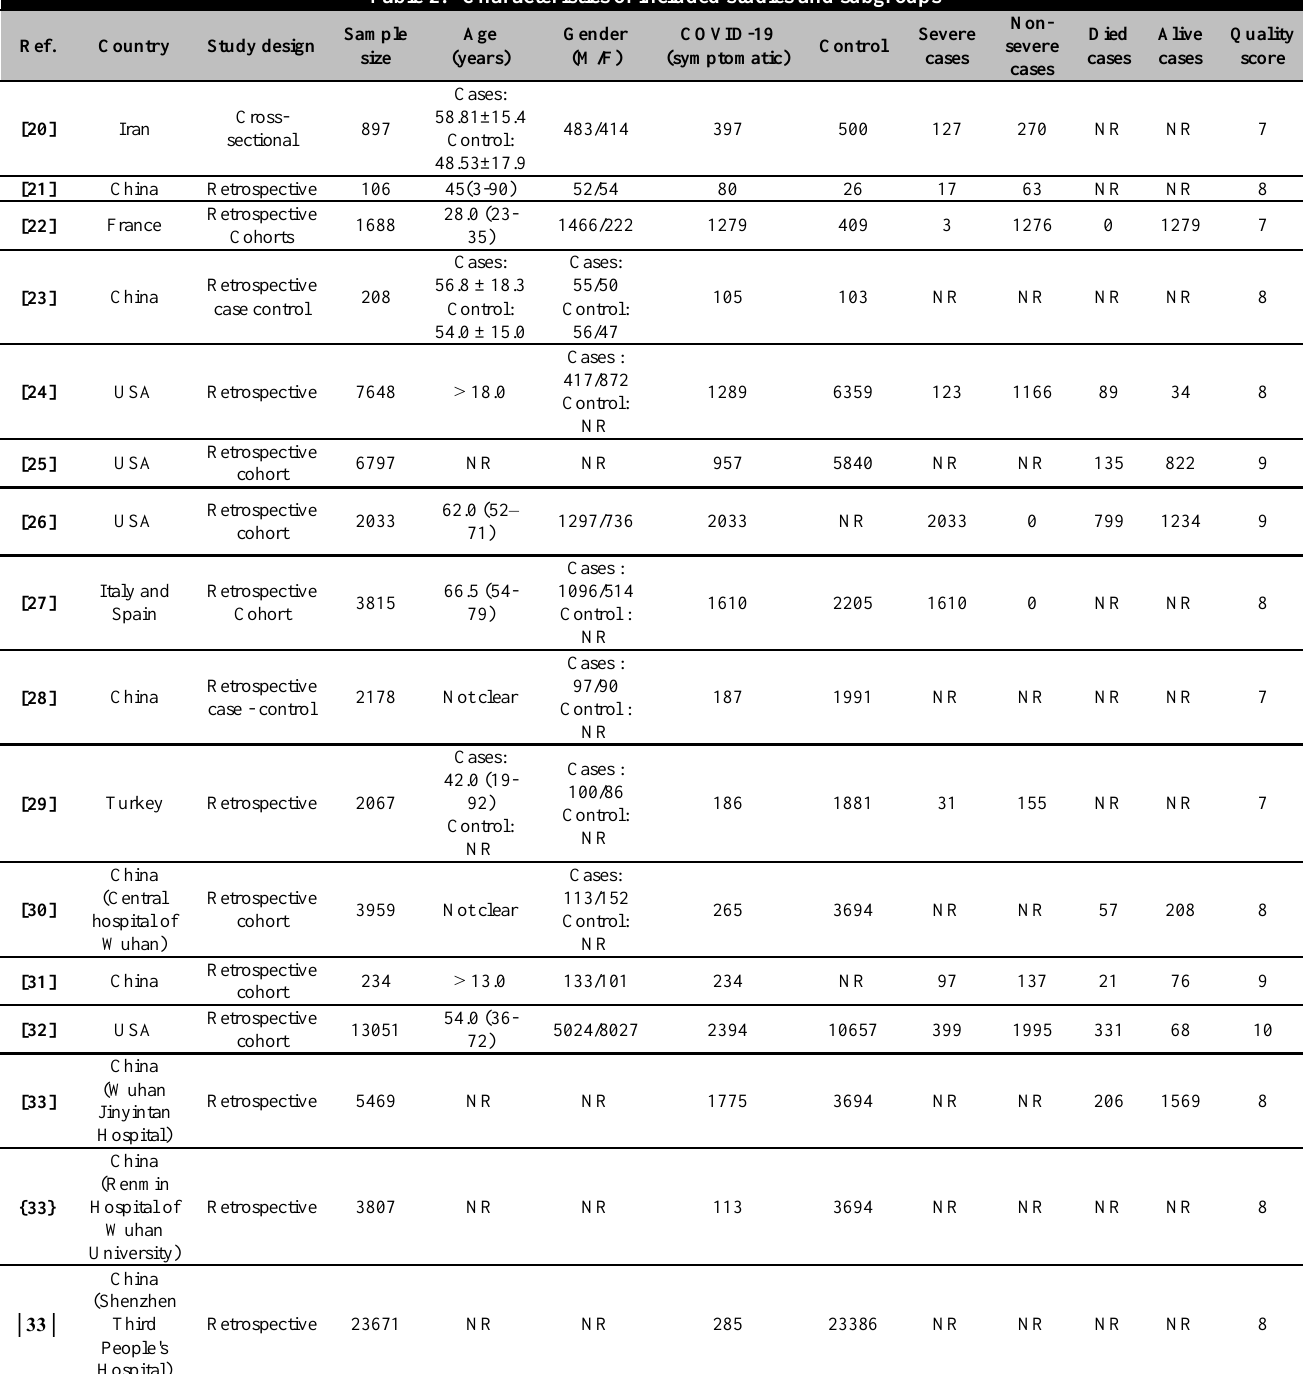
Table 2. Characteristics of included studies and